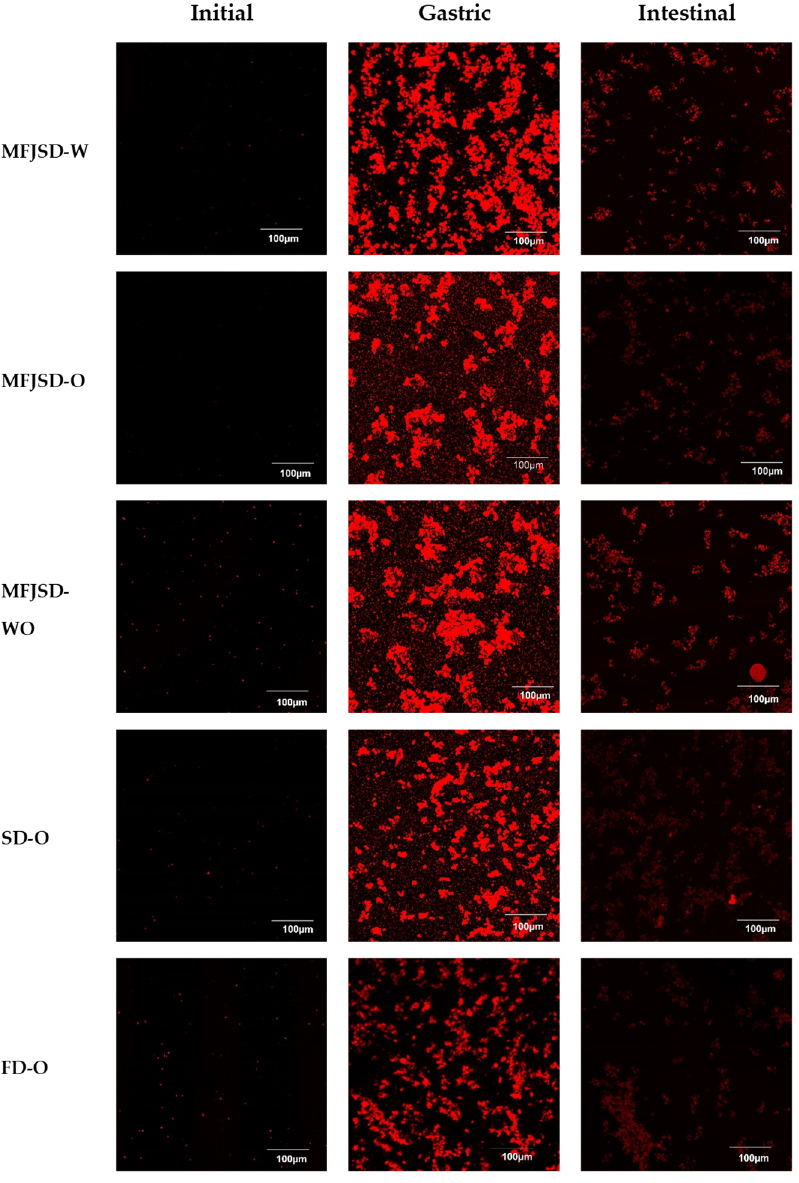
Figure 9. CLSM images showing the digestion behaviours of oil droplets in microcapsules after in vitro gastric and intestinal digestion. MFJSD-W, MFJSD-O, and MFJSD-WO: microcapsules pro- duced by microfluidic-jet spray drying, using WPI only, OSA only, and a combination of WPI/OSA (50/50 w/w ) as wall materials, respectively; SD-O: microcapsules produced by two-fluid nozzle spray drying, using OSA only as wall material; FD-O: microcapsules produced by freeze-drying, using OSA only as wall material; WPI: whey protein isolate; OSA: octenylsuccinic anhydride modified starch.